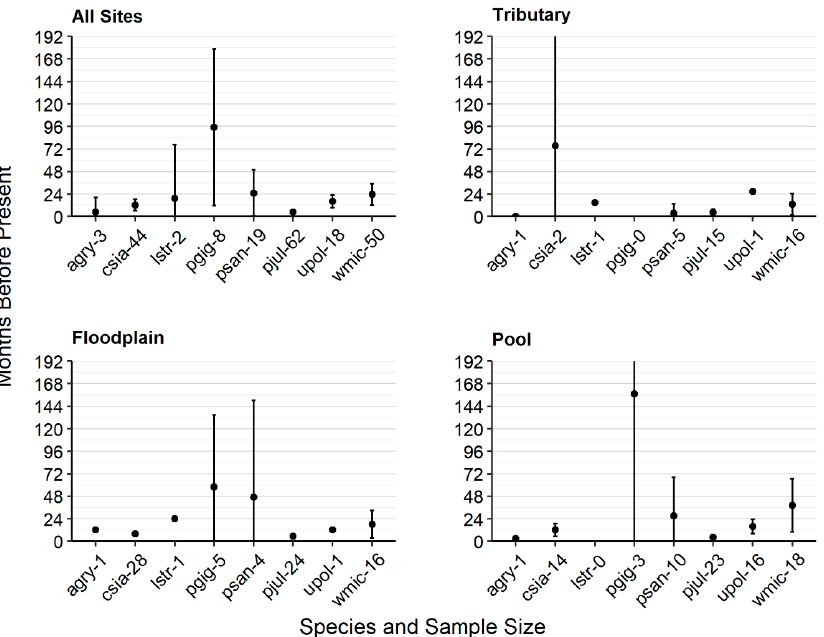
Figure 2. Rarity of Mekong megafishes in northern Cambodia. Species rarity is represented by the amount of time since the most recent capture by fishers in months before present (June 2018). Points and error bars are the means and 95% confidence intervals. Zero months before the present represents a specimen captured within a month of the survey. The number after the species abbreviation on the x-axis is the number of high-quality interviews obtained for that species. “All Sites” = data from all 12 villages where interviews were conducted; “Floodplain” = data from five villages in river sections that have close connectivity with the floodplain; “Pool” = data from five villages in river sections that have nearby deep pool habitat; “Tributary” = data from two villages on the Sekong and Srepok rivers, which are tributaries to the Mekong River. For species abbreviations, see Table 1.